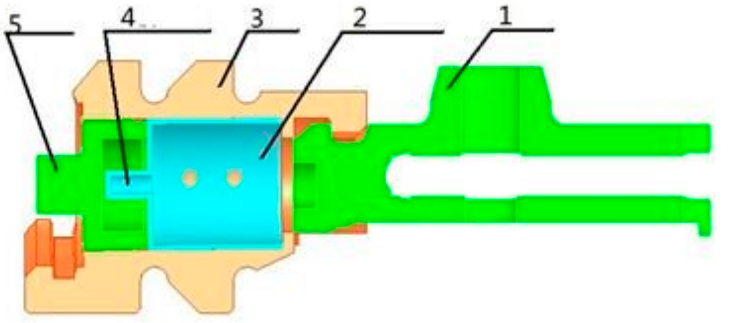
Figure 20. Test device structure. Note: 1—bolt body, 2—storage test device, 3—bolt head, 4—acceleration sensor, and 5—fixed lid.